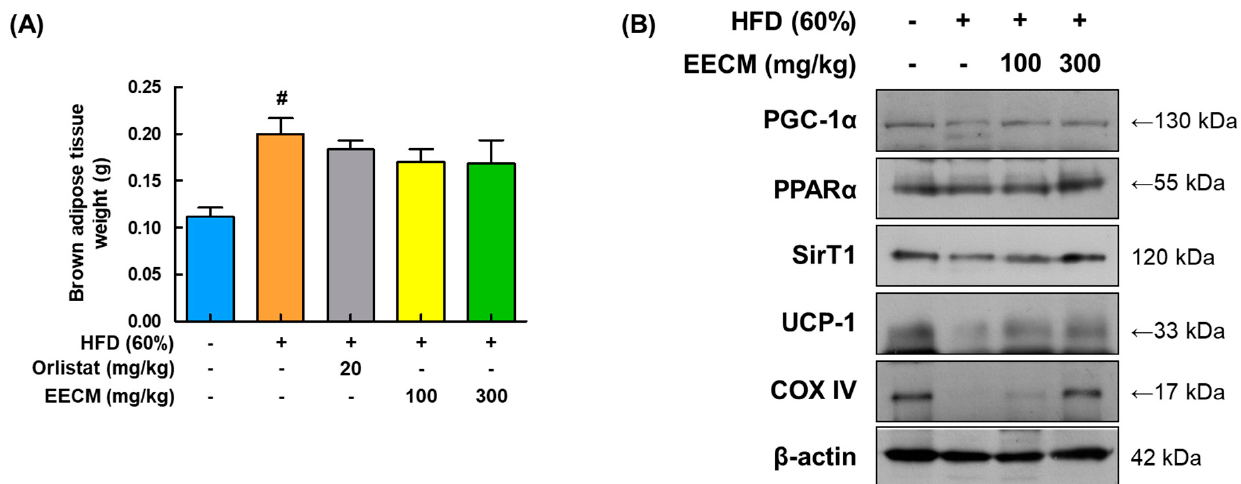
Figure 9. Stimulating effects of EECM on thermogenesis in the BAT. ( A ) Weights of BAT in each group. ( B ) Expression levels of thermogenesis-related proteins PGC-1 α , PPAR α , SIRT1, UCP-1, and COX-IV were determined via Western blotting analysis. Values are represented as the mean ± SEM ( n = 8/group). # p < 0.05 vs. the CON group.